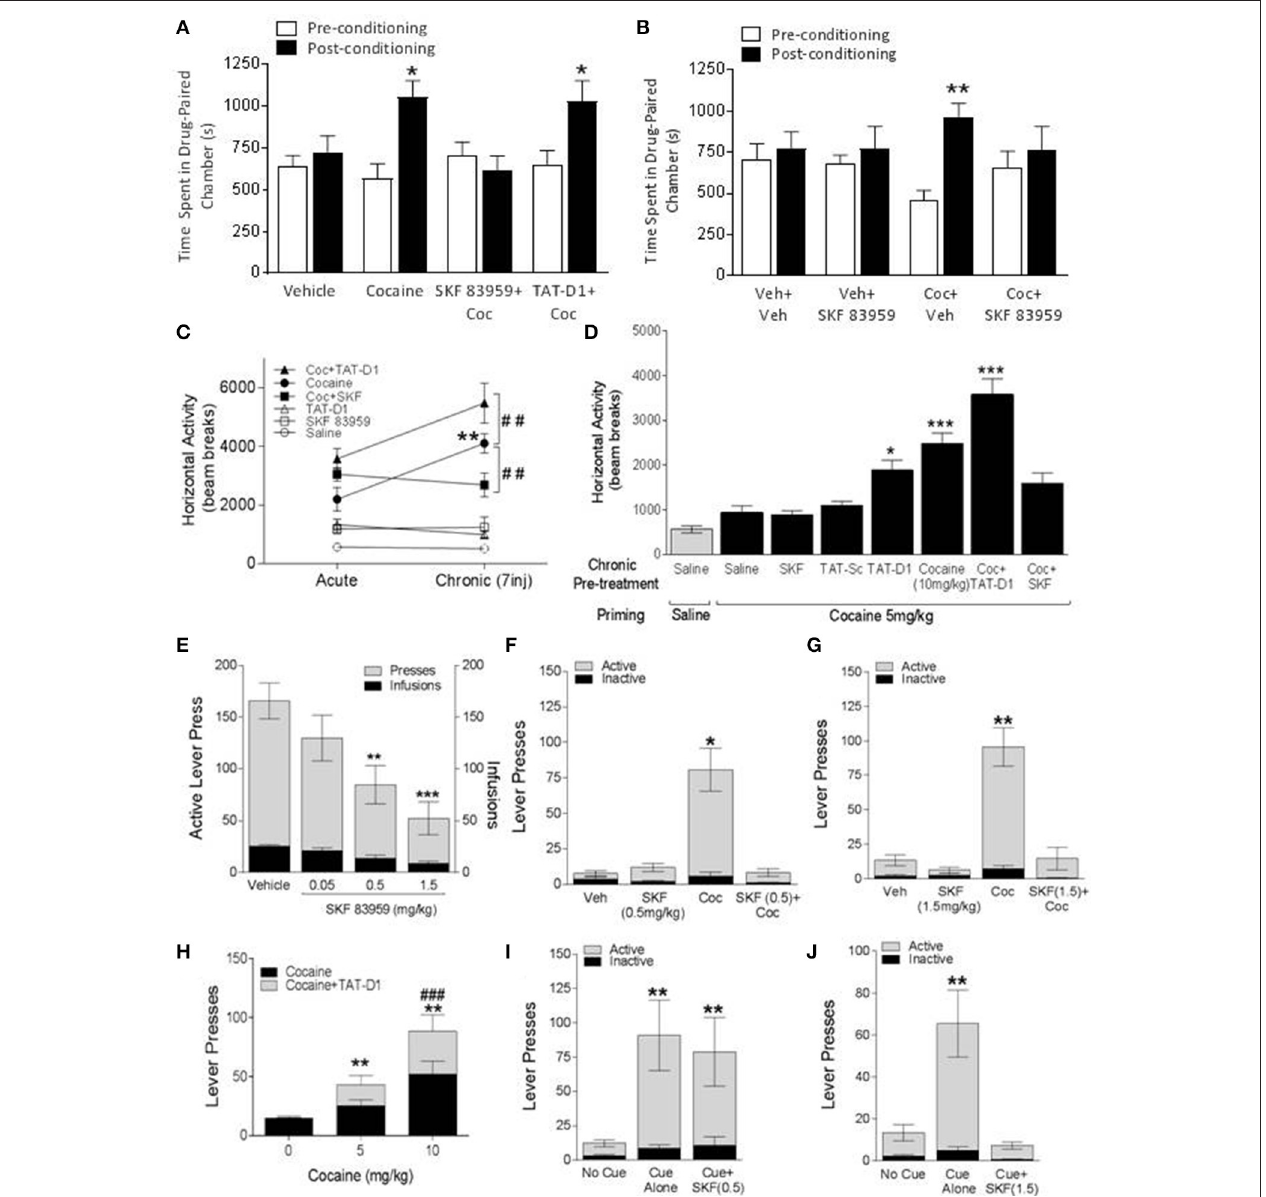
FIGURE 4 | The effects of D1-D2 heteromer stimulation and inactivation on cocaine-induced behaviors. (A,B) Effects on cocaine CPP. (A) Vehicle-conditioned rats did not exhibit a preference toward a particular chamber. Cocaine-conditioned animals exhibited conditioned place preference (CPP). The acquisition of cocaine CPP was abolished by SKF 83959 and enhanced by TAT-D1 peptide (300 pmoles, i.c.v.). (B) A single injection of vehicle or SKF 83959 did not affect the chamber preference of vehicle-conditioned animals but abolished the expression of cocaine CPP in cocaine-conditioned animals. Data in (A,B) represent means ± SEM. of n = 8–10 rats/group. (* p < 0.05, ** p < 0.01). (C,D) Locomotor sensitization. (C) Effects of acute and chronic (7 days) treatments with TAT-Sc (300 pmoles, i.c.v.), SKF 83959 (1.5 mg/kg), TAT-D1 peptide (300 pmoles, i.c.v.) and cocaine (10 mg/kg, i.p.) on locomotion. The locomotor sensitization induced by cocaine was abolished by